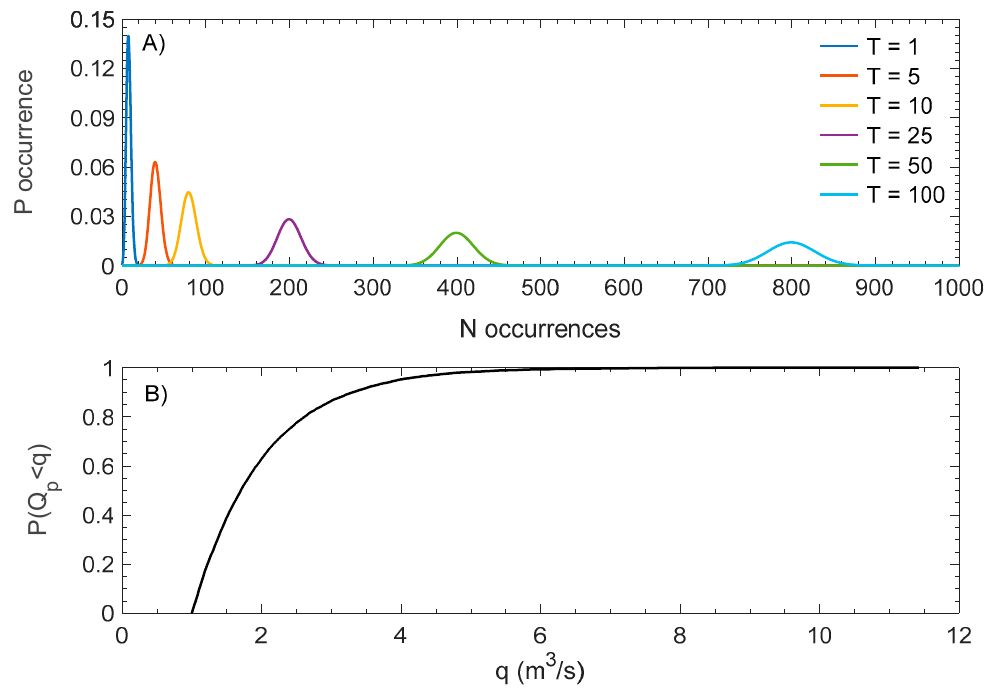
Figure 3. ( A ) Probability mass function of the number N of flood event occurrences with Q p > q 0 . ( B ) Empirical cumulative probability function of peak discharges for flood events with a magnitude Q p > q 0 .